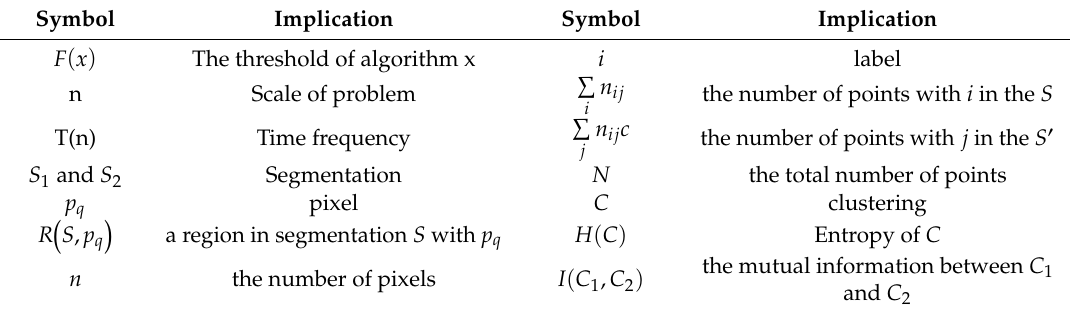
Table 9. The implication of the formula symbol in Section 4.